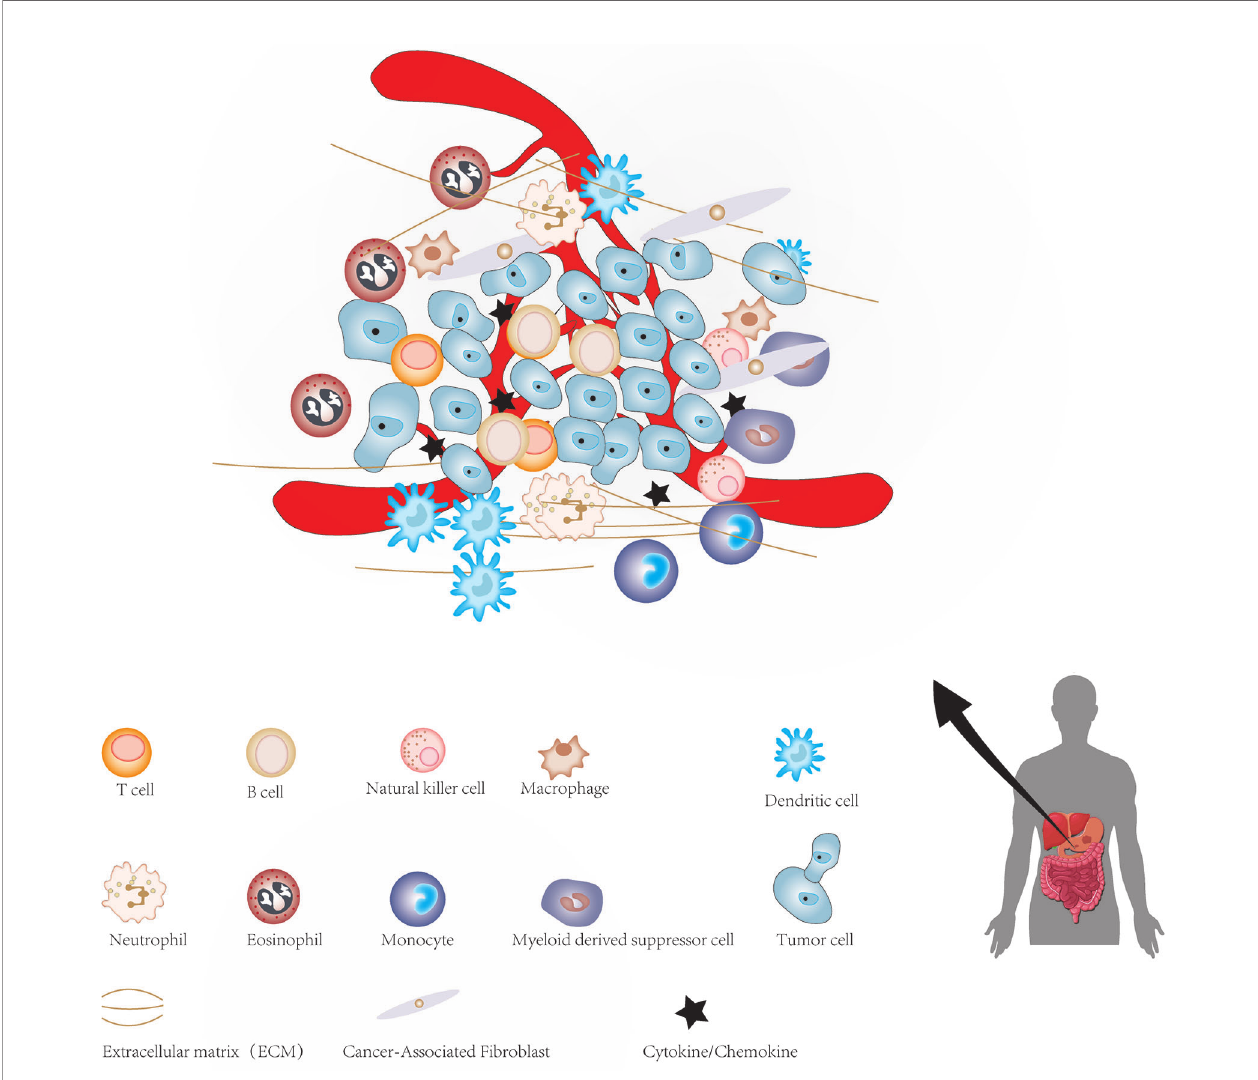
FIGURE 1 | The major constituents of the tumor microenvironment in gastric